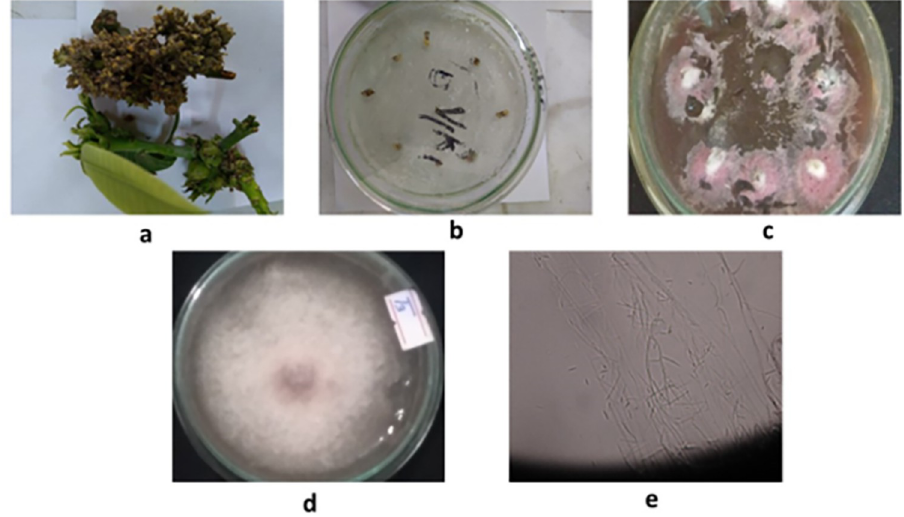
Fig 10. Procedure for isolation and identification of Fusarium mangifera causing mango malformation disease. (a) Infected inflorescence of Mangifera indica (b) Infected inflorescence were placed on PDA, (c) fungal colonies emerging from the inflorescence after 3–5 days at 28 ± 2˚C under alternative cycle of darkness and light in a Versatile Environmental Test Chamber, (d, e) Macro and micro morphological examination.